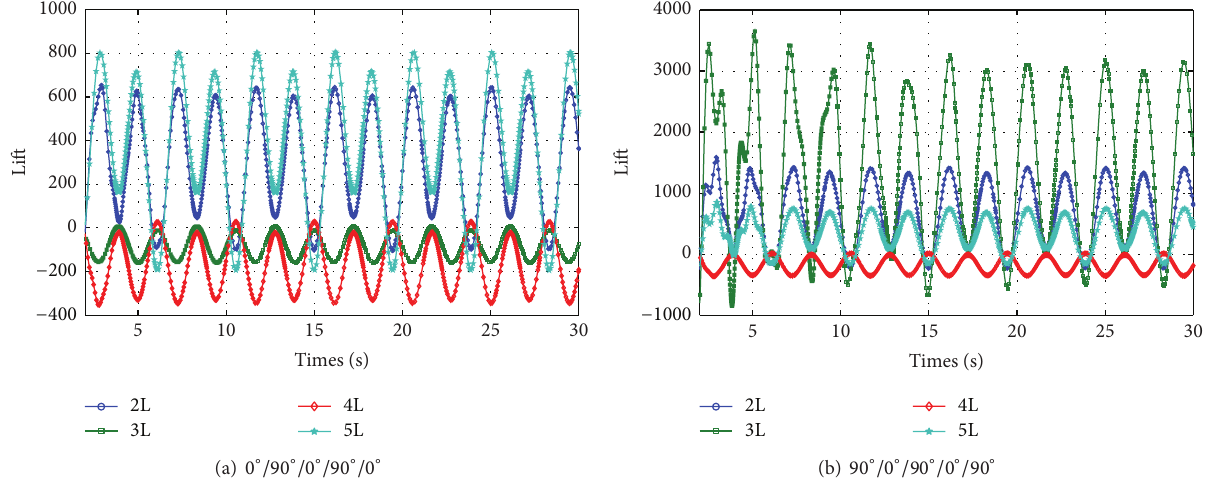
Figure 10: Lift of fin in the case of combined rotational and translational